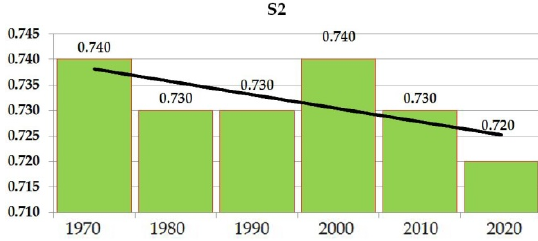
Figure 12. Coe ffi cient of the vegetation cover, S2 . Figure 12. Coefficient of the vegetation cover, S 2 . Figure 12. Coefficient of the vegetation cover, S 2 . Figure 12. Coefficient of the vegetation cover, S 2 .